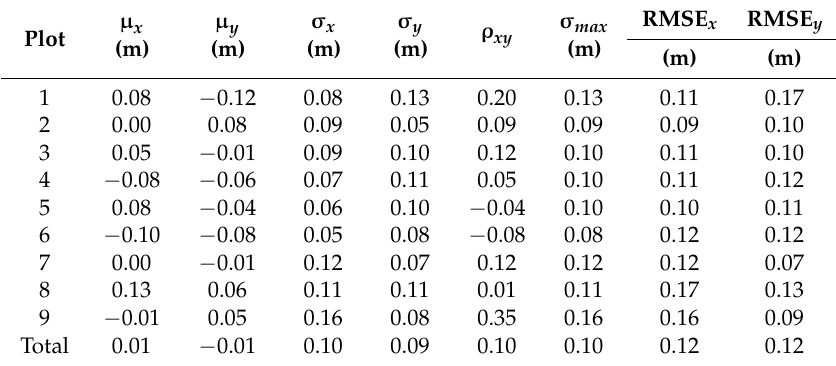
Table 2. Accuracy of the stem position estimations using the SLAM